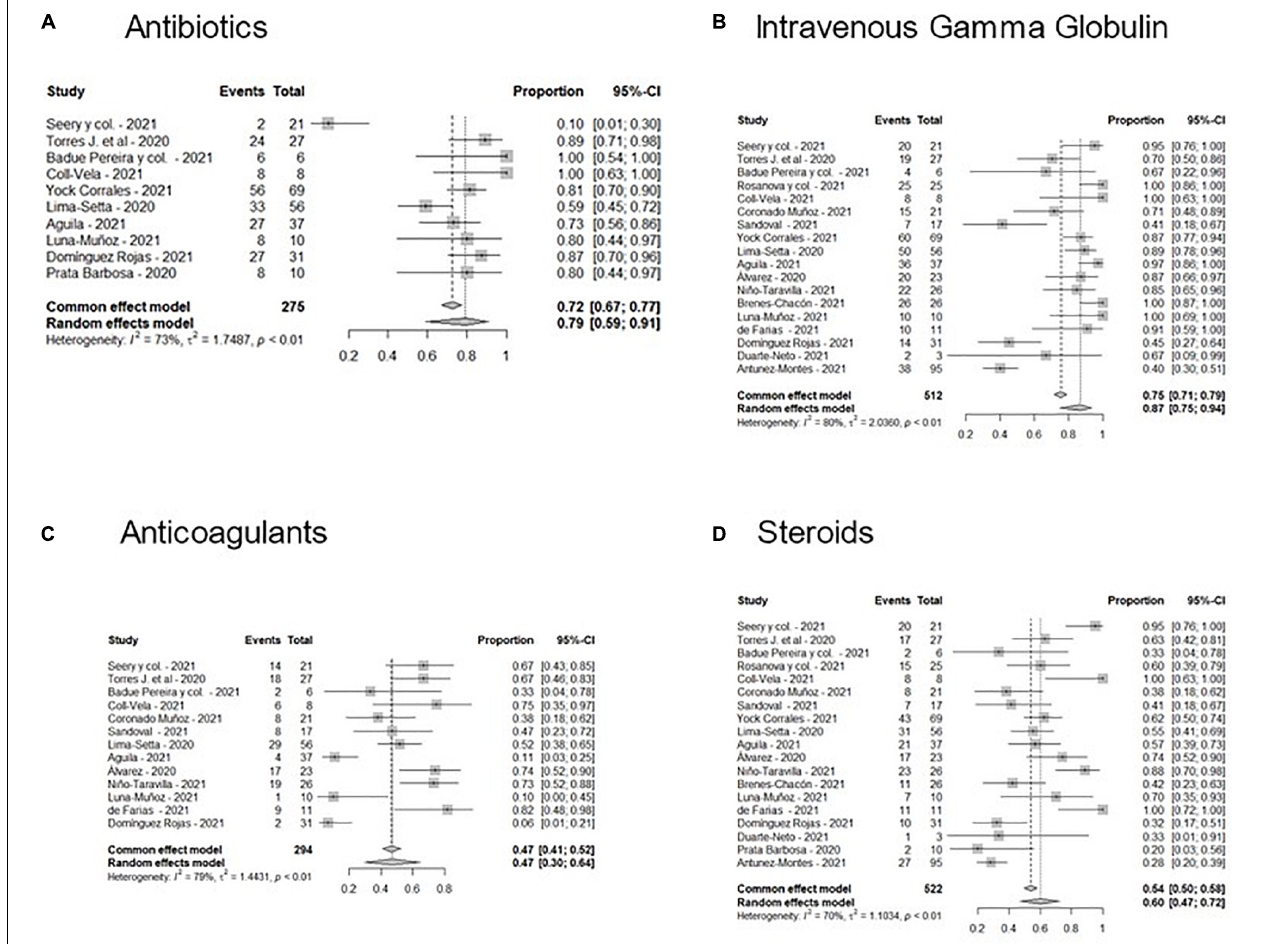
FIGURE 2 | Forest plots of the frequencies of treatments administered in MIS-C patients in Latin America. (A) Antibiotics, (B) Intravenous Gamma Globulin, (C) Anticoagulants, and (D) Steroids.